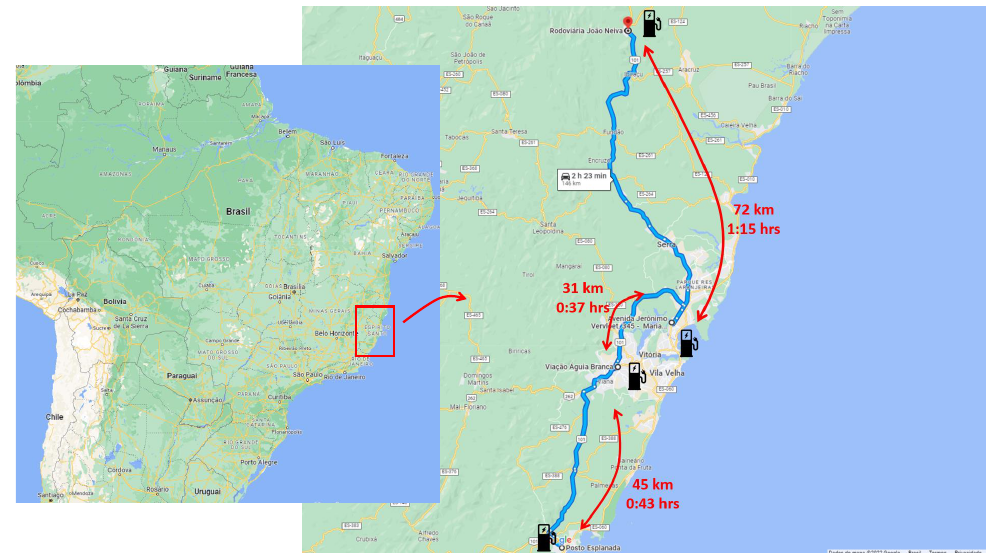
Figure 2. Charging infrastructure implemented in Espírito Santo during the R&D project.